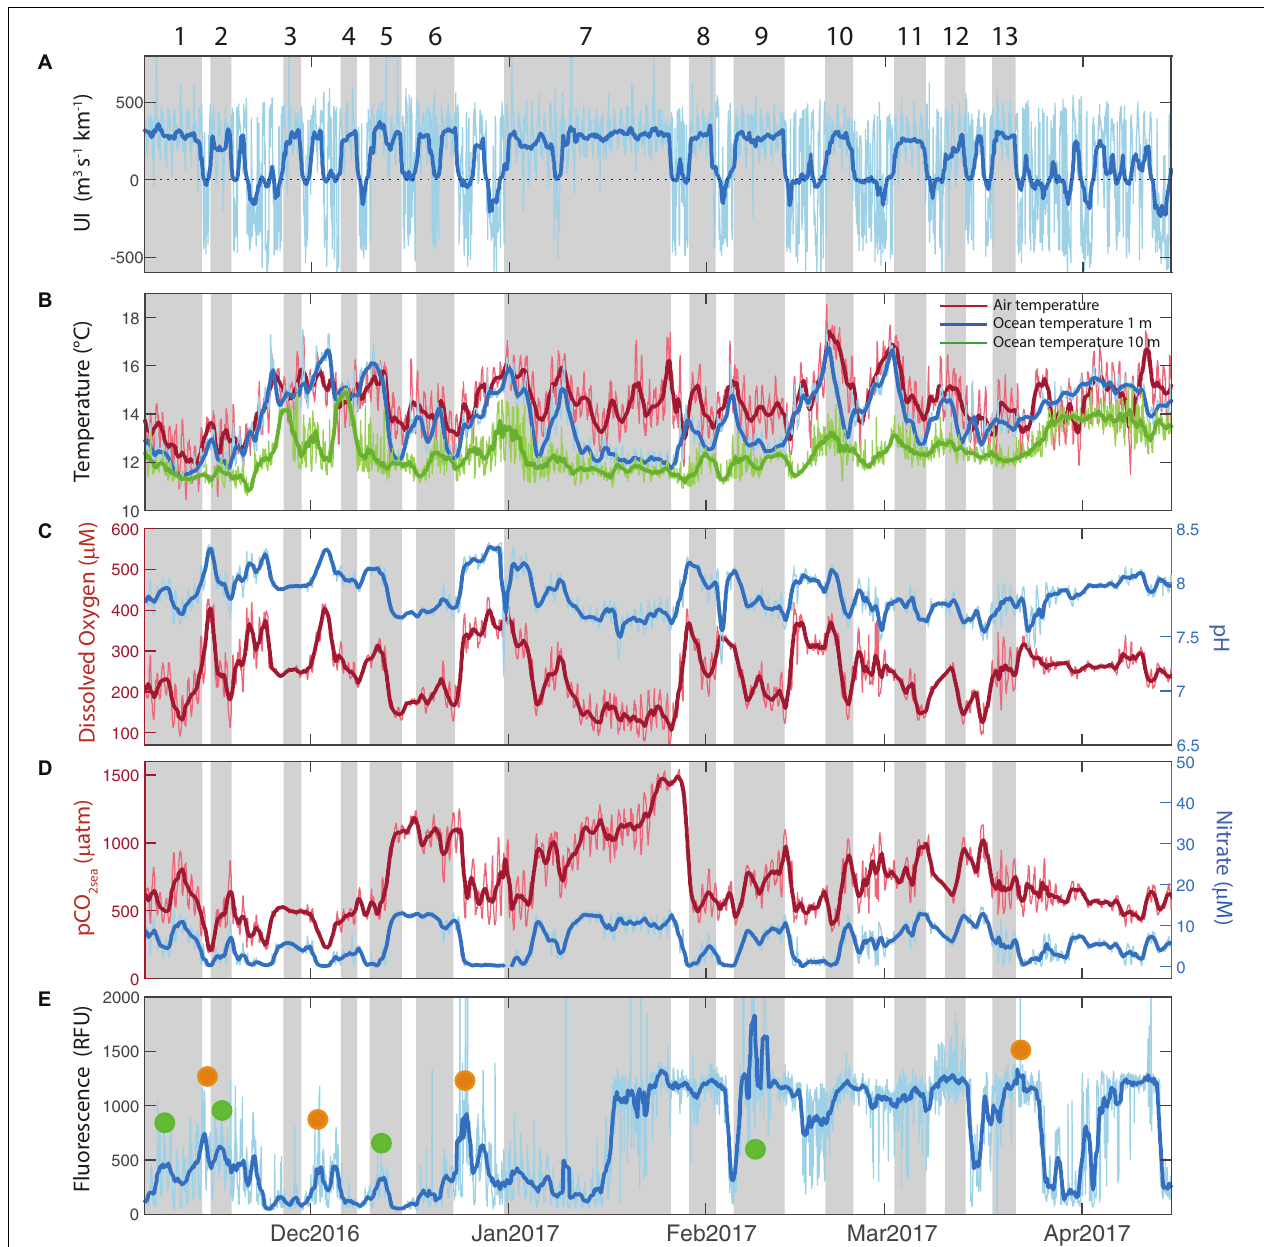
FIGURE 2 | Hourly (thin line) and filtered (thick line) time series between November 2016 and April 2017. Vertical gray bars indicate the periods of the upwelling events. (A) Upwelling Index (m 3 s − 1 km − 1 ), (B) Air temperature ( ◦ C, red line), ocean temperature at 1 m depth (blue line) and ocean temperature at 10 m depth (green line), (C) Dissolved Oxygen ( µ M, red line) and pH (blue line), (D) p CO 2 sea ( µ atm, red line) and Nitrate ( µ M, blue line) and (E) Fluorescence (RFU). Green dots indicates when fluorescence increases during upwelling events and orange dots indicates when fluorescence increases after upwelling